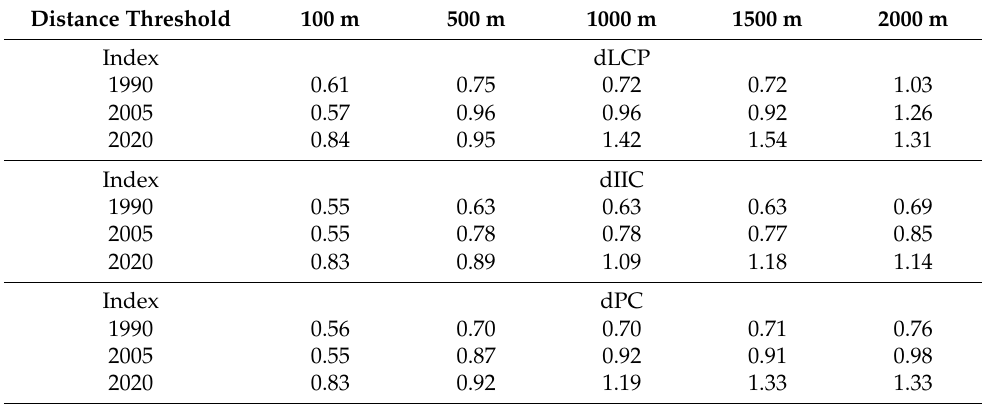
Table 3. Contribution rate of the connectivity index at different distance